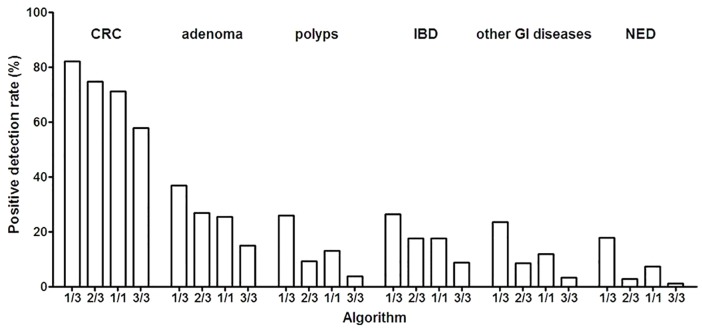
Algorithm affects the detection performance on various colorectal diseases.The positivity detection rate was shown for serveral types of colorectal diseases. in the opportunistic screening using various algorithm. Data was shown for CRC, adenoma, polyps, IBD, other GI diseases and NED with 1/3, 2/3, 1/1 and 3/3 algorithm.